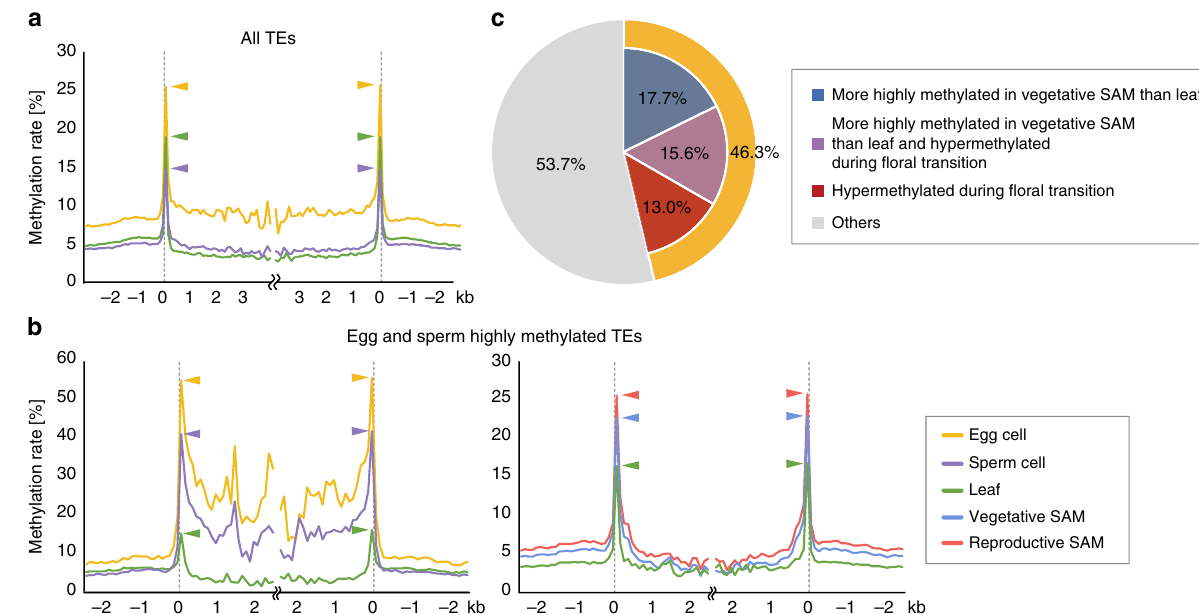
Fig. 5 Many TEs highly methylated in germ cells undergo CHH hypermethylation in SAM. a and b Metagene plots show patterns of DNA methylation for the CHH context in the egg cell (orange), sperm cell (purple), leaf (green), vegetative SAM (blue), and reproductive SAM (red) for all TEs a and TEs hypermethylated in the egg cell and sperm cell relative to the leaf b . Reported data for egg cell 16 , sperm cell 31 , and mature leaf 15 were re-analyzed using our methods. c Ratio of TEs that are hypermethylated in vegetative SAM compared with leaf (blue), hypermethylated in reproductive SAM compared with vegetative SAM (red), and hypermethylated in vegetative SAM and reproductive SAM compared with leaf (purple) to TEs hypermethylated in germ cells compared with leaves in the CHH